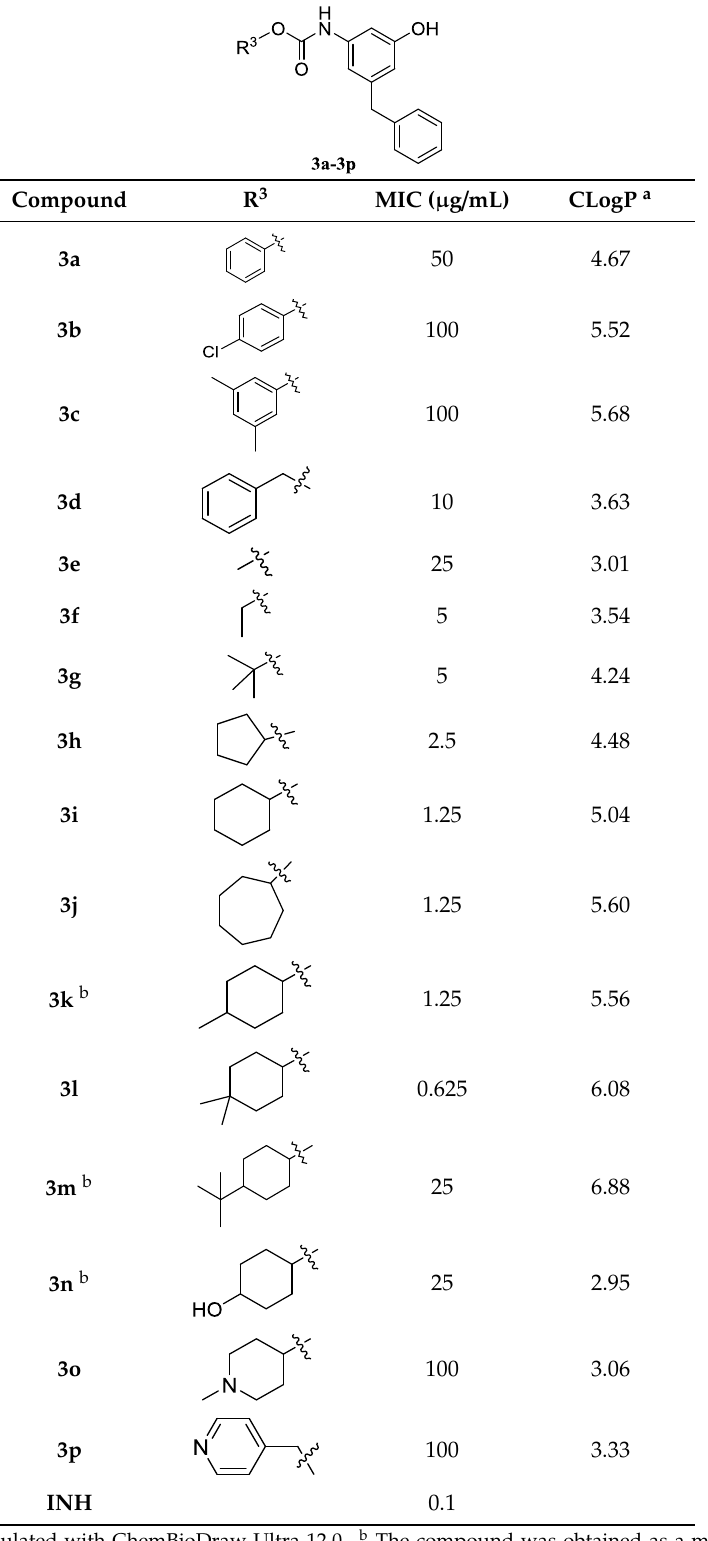
Table 2. Inhibitory activity of 3a – 3p against Mtb H37Ra.